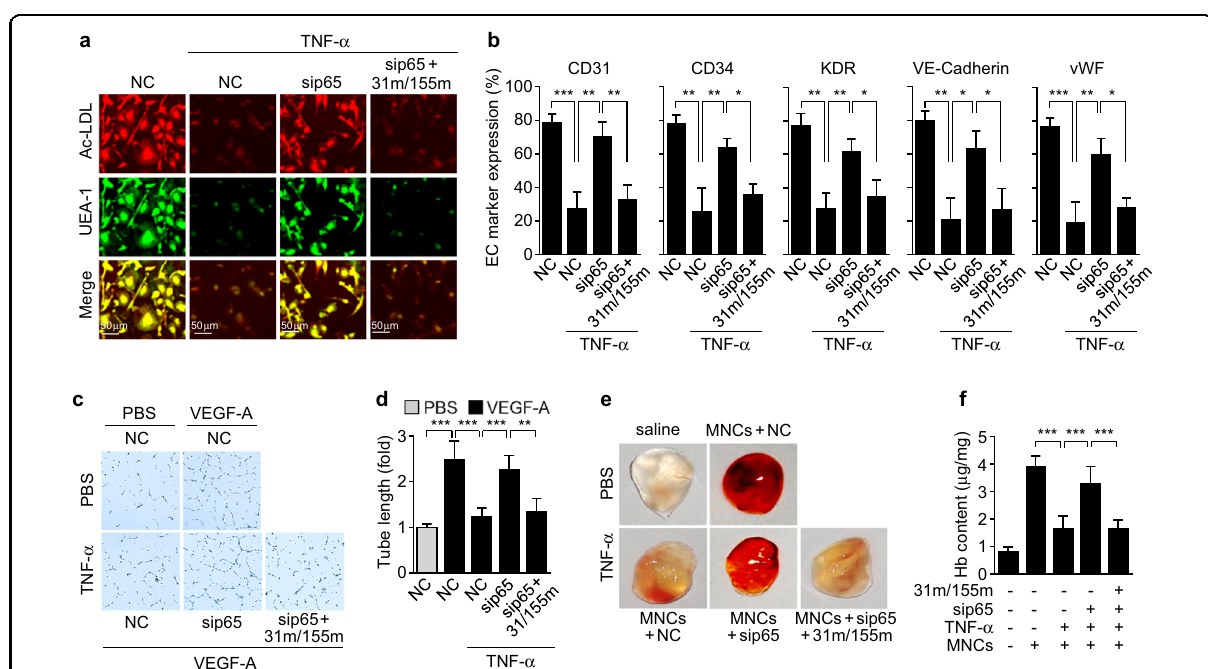
Fig. 6 TNF- α inhibits EPC differentiation via NF- κ B-dependent biogenesis of miR-31/155. CBMNCs (MNCs) were transfected with negative control (NC), NF- κ B p65 siRNA (sip65), or miR-31/155 mimics (31 m/155 m), followed by treatment with or without TNF- α . a Representative images of EPCs characterized by double-positive staining with Dil-ac-LDL and FITC-UEA-1. b Cells were labeled with antibodies against EPC marker proteins and analyzed by fl ow cytometry ( n = 3). c , d Tube formation of EPCs in response to VEGF-A was photographed using an inverted microscope and quantitated using ImageJ software ( n = 4). e , f Matrigel containing low-dose VEGF-A (5 ng/ml) was mixed with or without 2 × 10 5 EPCs differentiated from CBMNCs and subcutaneously injected into athymic nude mice. e After 8 days, the Matrigel plugs were harvested and photographed. f The hemoglobin (Hb) content in Matrigel plugs was determined using Drabkin ’ s reagent ( n = 4). * P < 0.05, ** P < 0.01, and *** P <